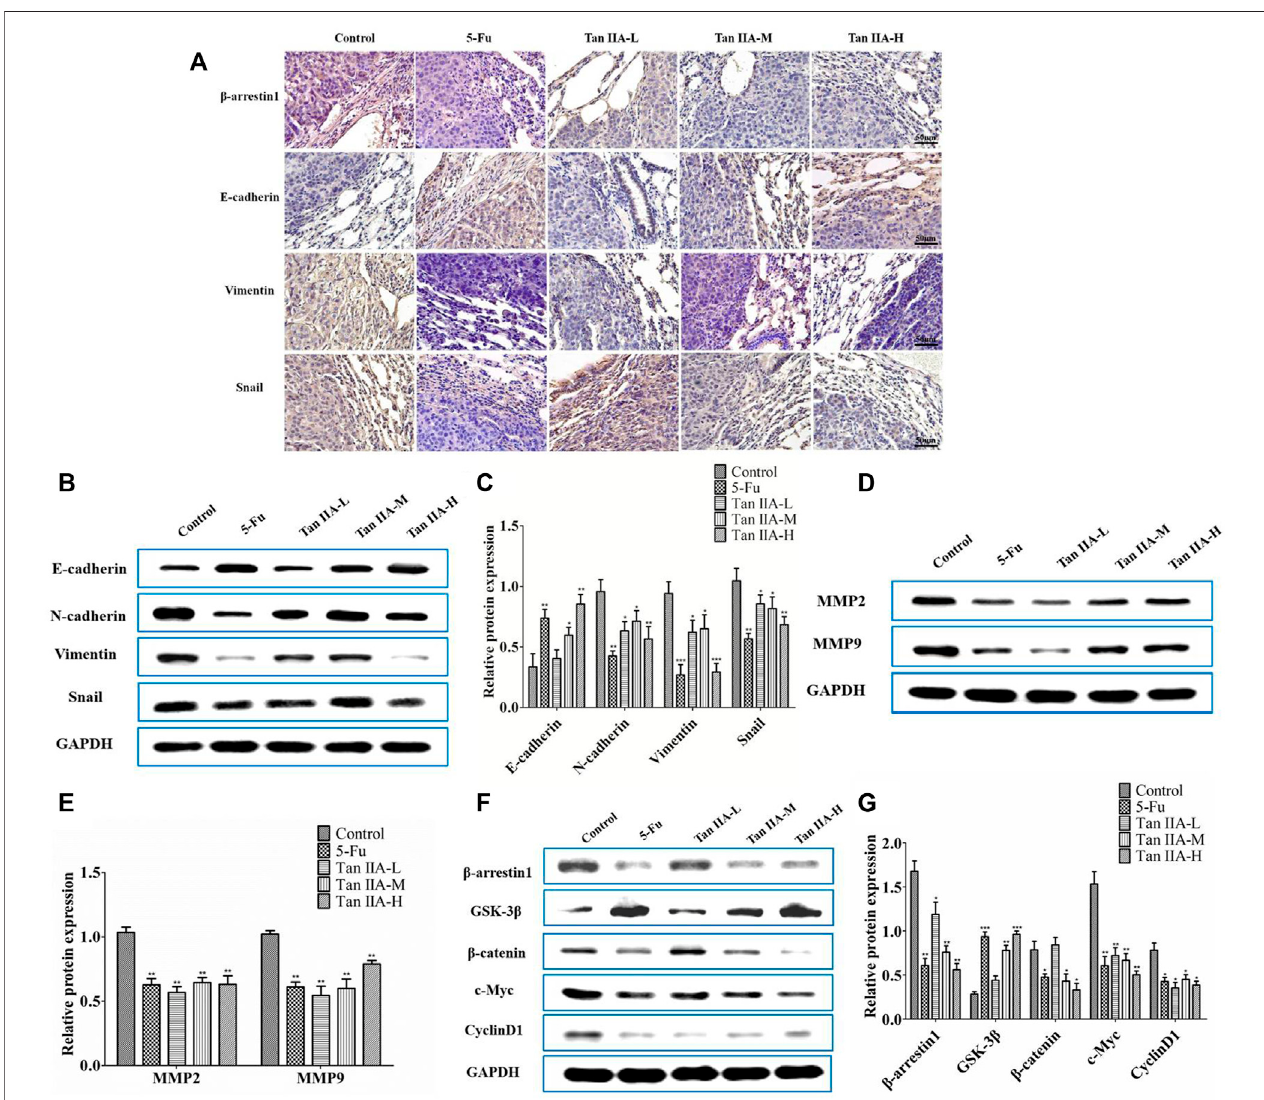
FIGURE 5 | Tan IIA inhibited metastasis of CRC via β -arrestin1/ β -catenin signaling pathway in vivo . (A) Immunohistochemistry on the expression of β -arrestin1, E-cadherin, Vimentin, and Snail in lung tumor tissues. (B,C) Western blot on the expression of E-cadherin, N-cadherin, Snail, and Vimentin, * p < 0.05; ** p < 0.01; *** p < 0.001, compared with control group. The experiment was performed three times with similar results. (D,E) Western blot on the levels of MMP-2 and MMP-9. The data were presented as the mean ± SD from at least three experiments. ** p < 0.01, compared with control group. (F,G) Western blot on the protein expression of β - arrestin1, GSK3 β , β -catenin, c-Myc, and CyclinD1. * p < 0.05; ** p < 0.01; *** p < 0.001, compared with control group. The data were presented from at least three experiments.